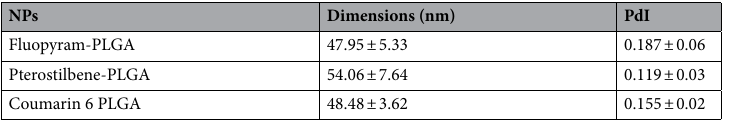
Table 1. Dimensions and Polydispersity Indexes (PdI) of PLGA-based NPs, measured by DLS. Values are referred to as mean ± standard deviation.